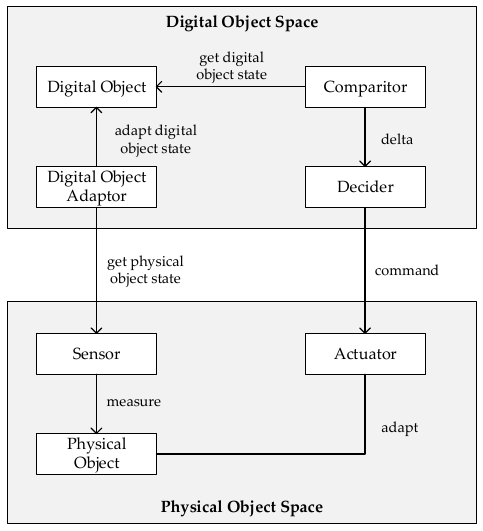
Figure 6. A conceptual model for control-based digital twin as derived from the literature.